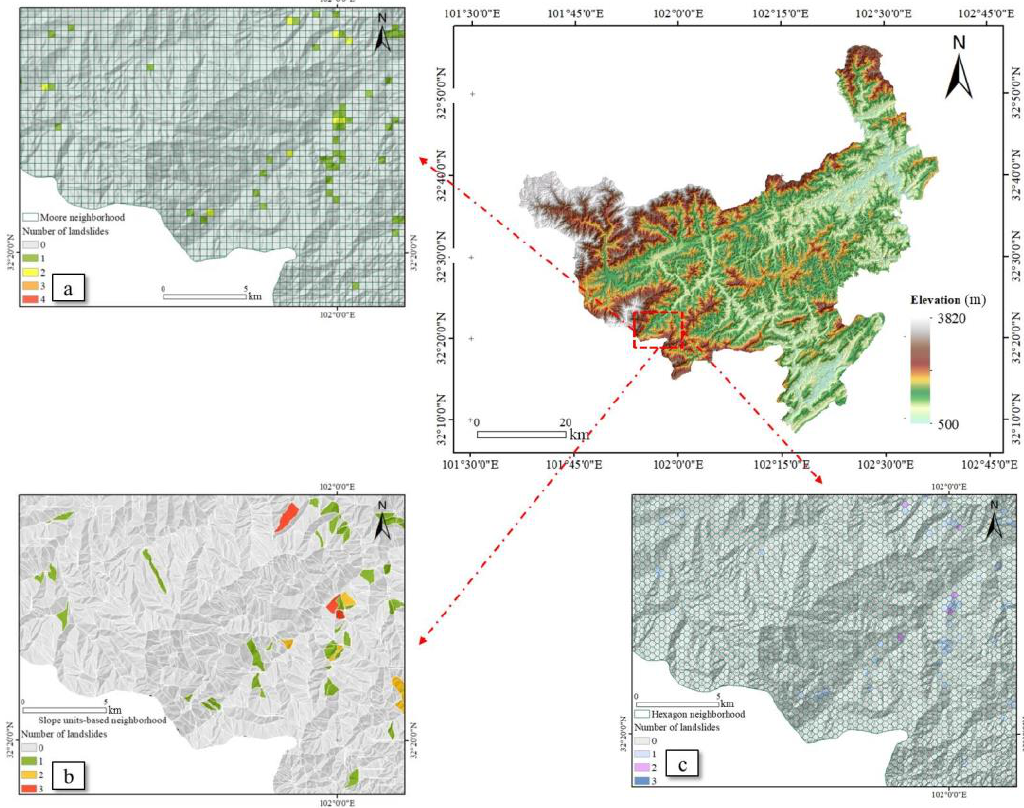
Figure 4. Schematic diagram of spatial proximity in Qingchuan county: ( a ) Moore neighborhoods, ( b ) slope-unit-based neighborhoods, ( c ) hexagonal neighborhoods.